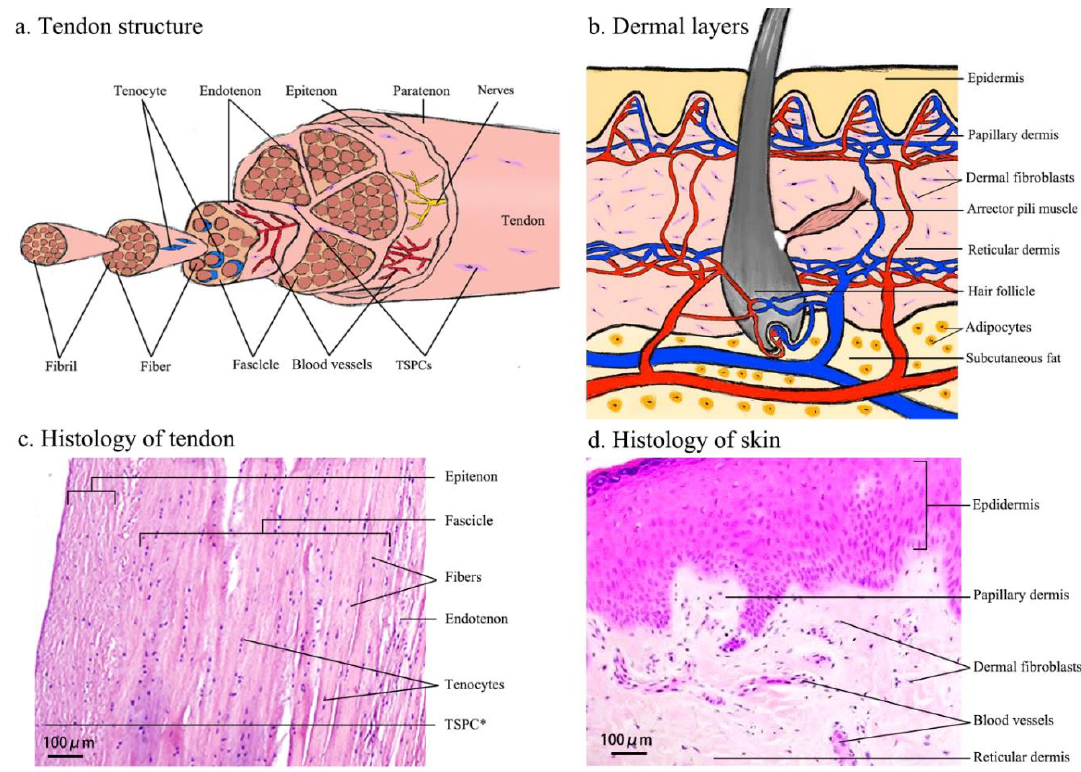
Figure 2. Cartooned images of the anatomical structure of human tendon ( a ) and skin ( b ), and light microscopy images of Hematoxylin & Eosin-stained tissue sections of human biceps tendon ( c )